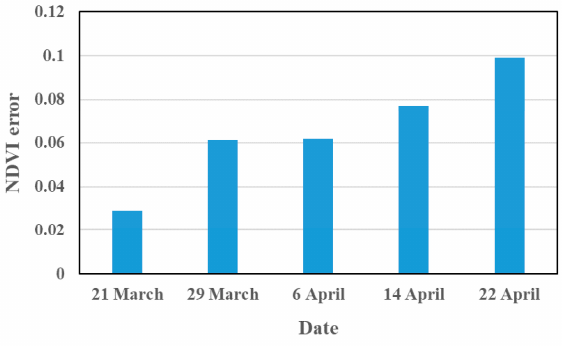
Figure 9. The error between the predicted NDVI average value and the real NDVI average value.